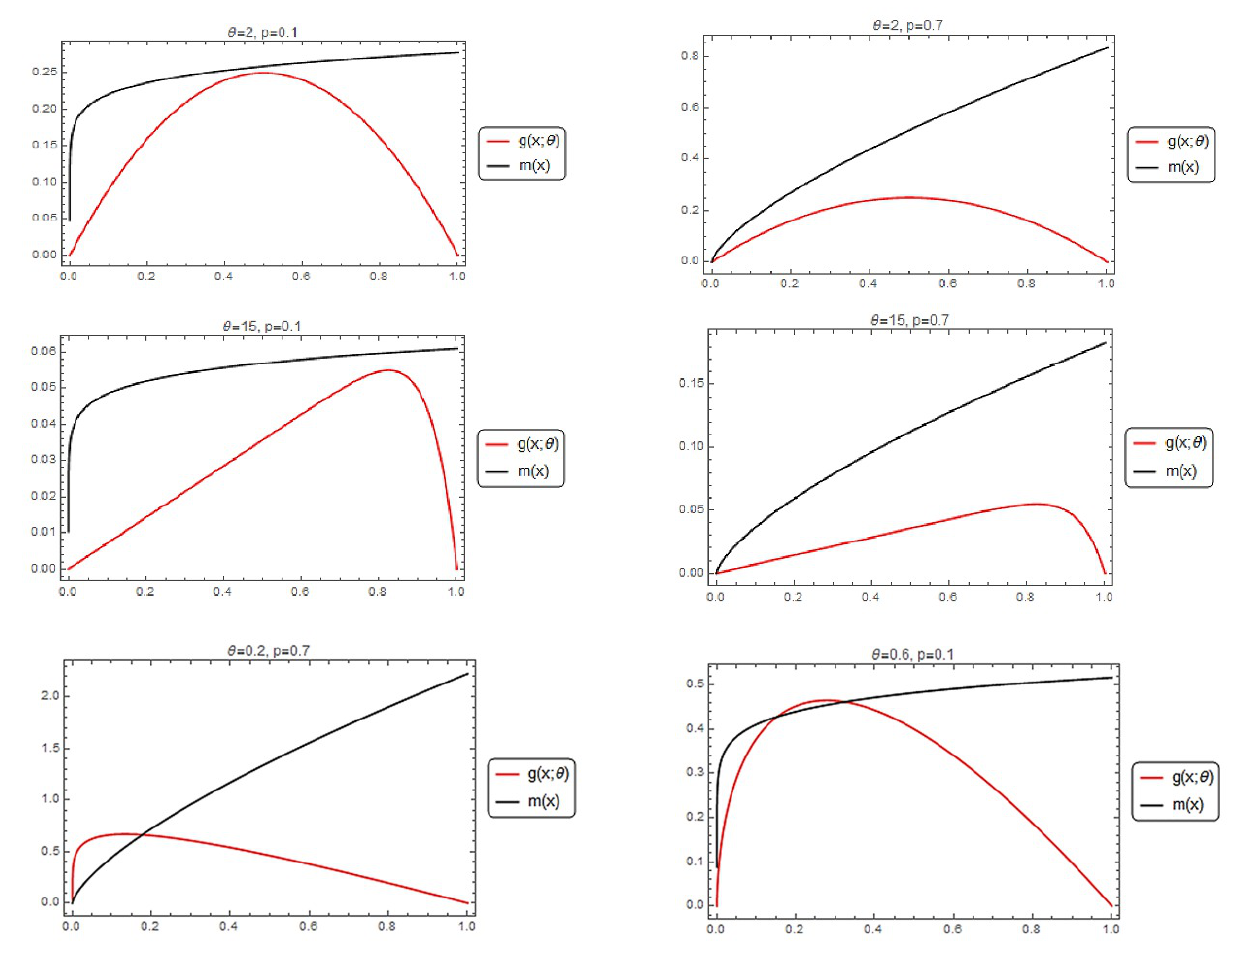
Figure 1. The relation between the functions g ( x ; θ ) and m ( x ) : = θ θ 1 − θ L ( x ; p ) with different values of θ and 0 < p <